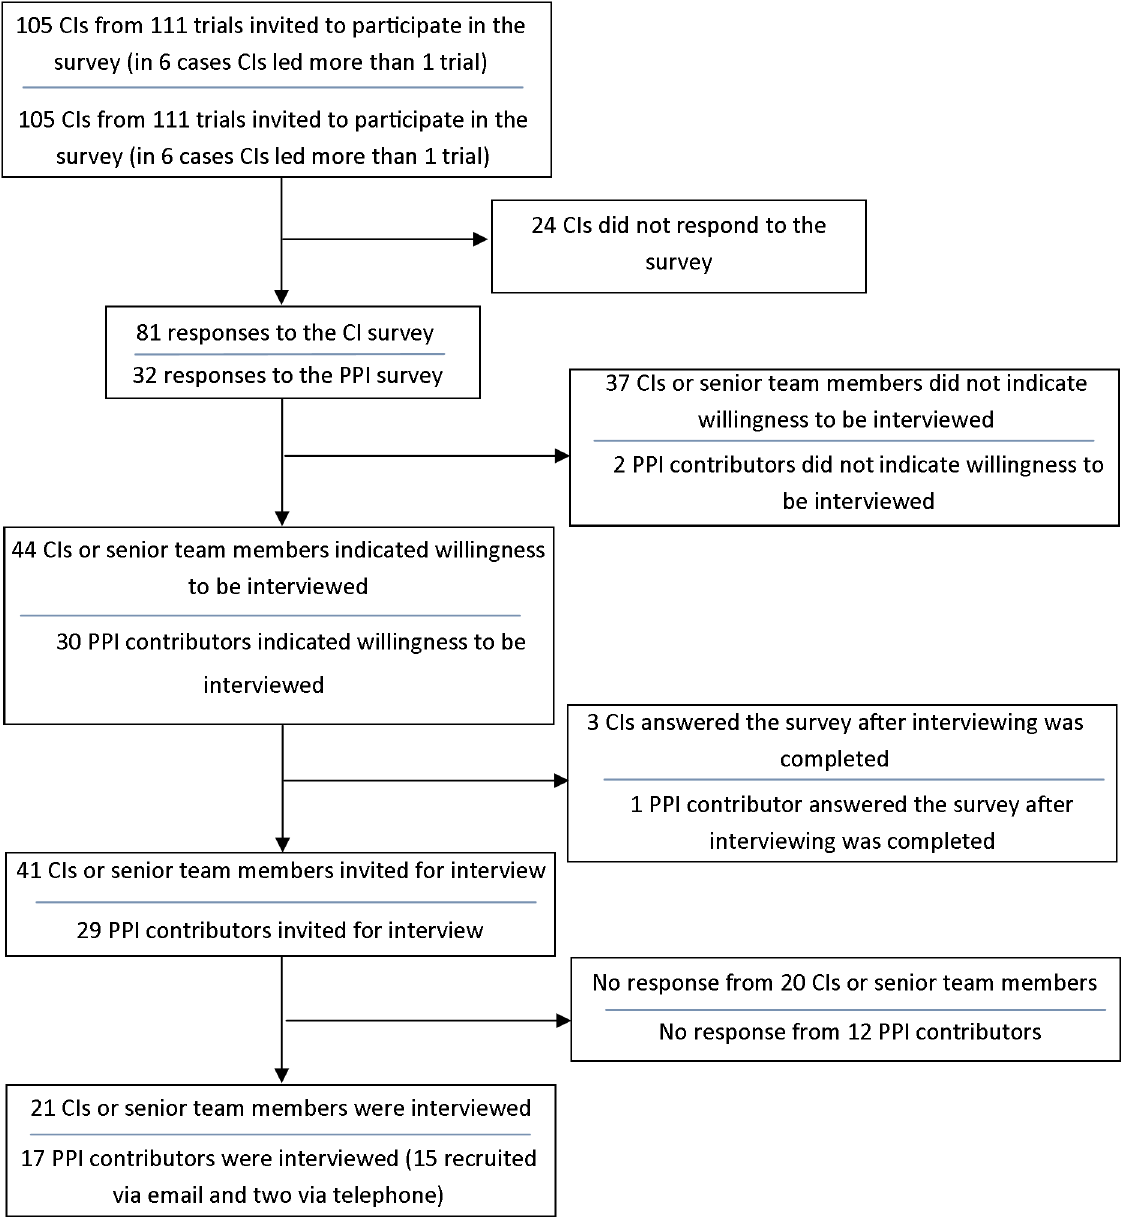
Fig 1. Flow diagram illustrating CI and PPI contributor